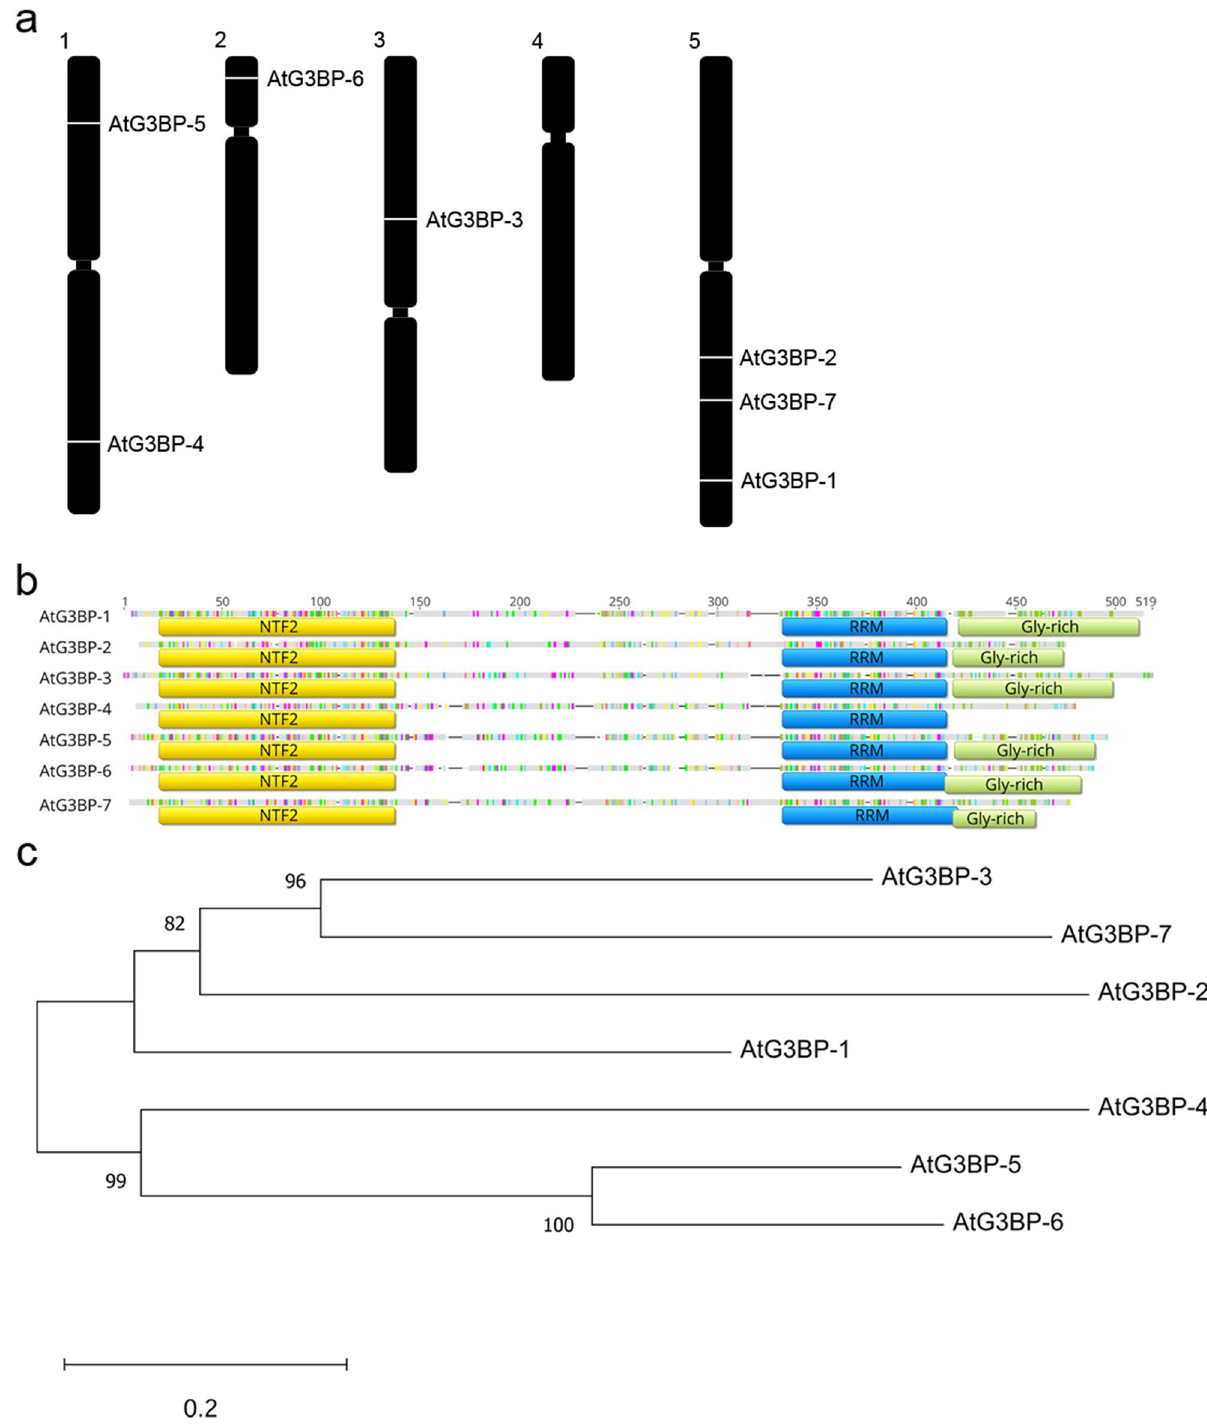
Figure 1. Relationship of the G3BP-like gene family in A. thaliana . ( a ) Genomic location of the different G3BP- like gene family in A. thaliana . The image was drawn using Adobe Photoshop CS4 (https ://www.adobe .com/ de/produ cts/photo shop.html). ( b ) Schematic alignment of the seven G3BPs from A. thaliana generated with Geneious Prime® 2020 software. Nuclear transport factor 2 (NTF2), RNA-binding (RRM), and Gly-rich domains are annotated and highlighted with yellow, blue and green boxes, respectively. ( c ) The evolutionary history was inferred as described in the methods section. The optimal tree with the sum of branch length = 3.69183953 is shown. The tree is drawn to scale, with branch lengths in the same units as those of the evolutionary distances used to infer the phylogenetic tree. This analysis involved 7 amino acid sequences. All ambiguous positions were removed for each sequence pair (pairwise deletion option). There were a total of 524 positions in the final